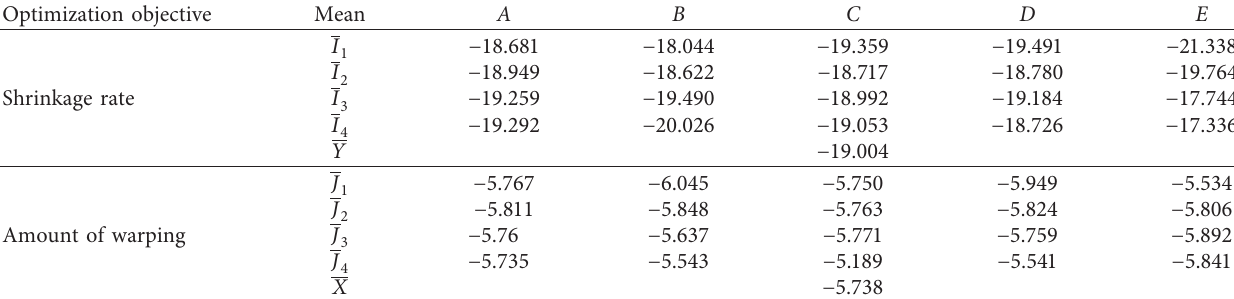
Table 5: Mean signal-to-noise ratio of shrinkage and warpage.